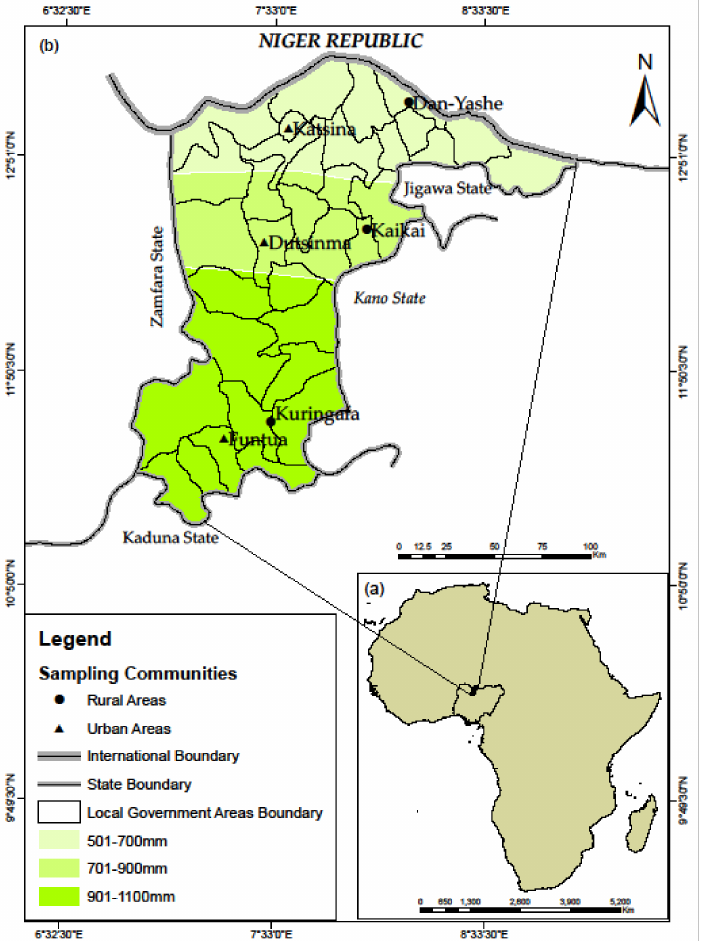
Figure 1. Maps of ( a ) Africa; and ( b ) Katsina state showing sampling communities across the isohyets. The state population projected data issued by the National Population Commission indicated that the total population for the year 2019 was about 8,613,100, out of which 4,565,000 (53%) and 4,048,100 (47%) are located in rural and urban communities,